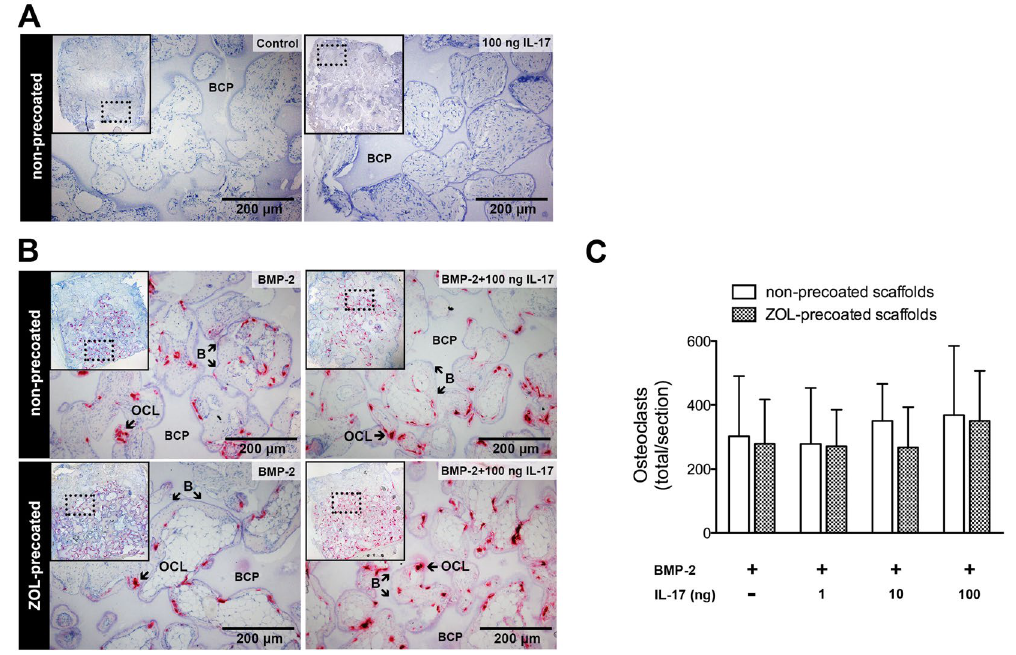
Figure 9. Presence of osteoclasts in the newly formed bone after 12-week implantation. ( A ) Tartrate-resistant acid phosphatase (TRAP) staining for osteoclasts was performed on empty biphasic calcium phosphate (BCP) scaffolds (control) or scaffolds loaded with IL-17 (100 ng/construct). ( B ) ZOL- coated and non-coated scaffolds were loaded with BMP-2 (3 μ g/construct) with or without IL-17 (100 ng/construct) and implanted subcutaneously. TRAP staining shows the presence of bone (B)-lining osteoclasts (OCL, in red). The images for this IL-17 concentration are representative for all IL-17 concentrations. ( C ) Osteoclast counts are represented as the mean ± SD (n =